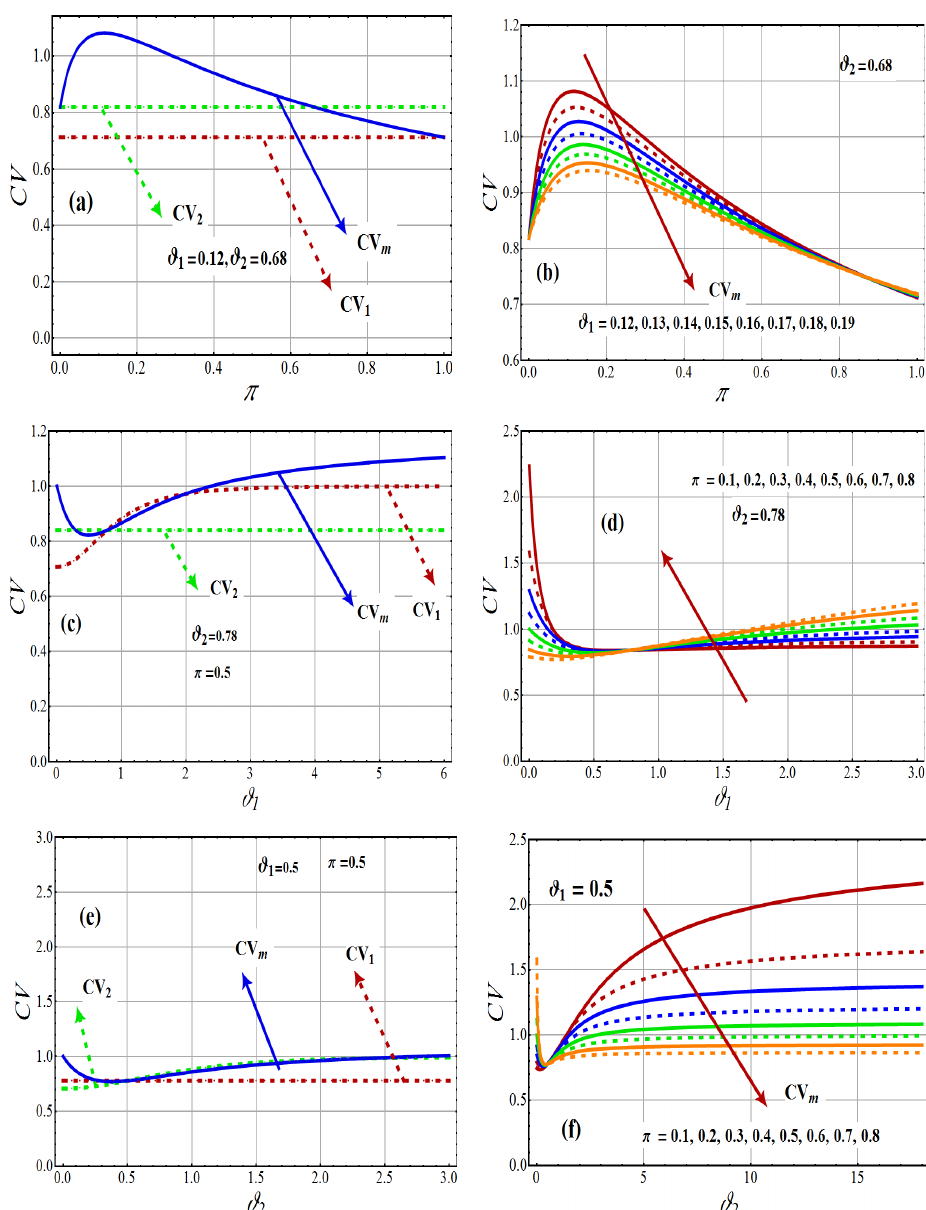
Fig. 4. Variations of Coe¢ cient of Variation, for (cid:133)rst component (CV Figure 4. Variations of coefficient of variation, for first component (CV 1 ), for second component (CV ) and for 2-CMSM (CV (CV 2 ), and for 2-CMSM (CV m 2